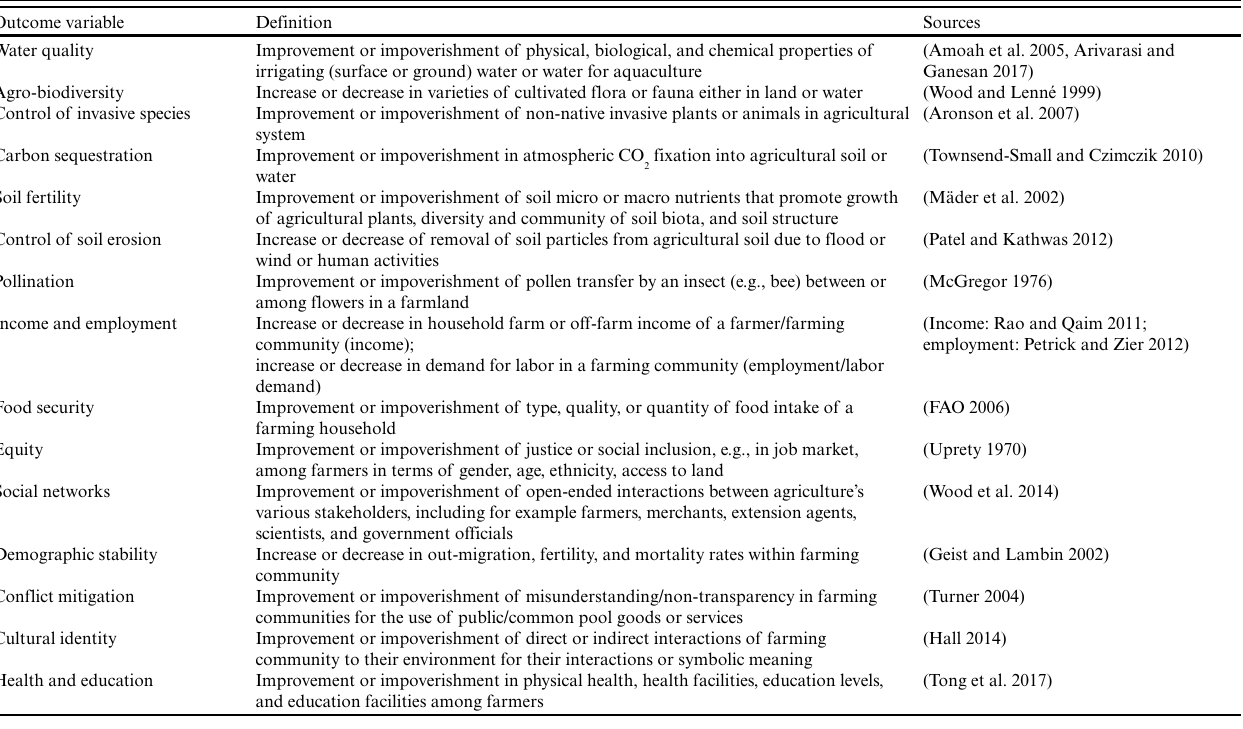
Table 1 . Outcome variables, their definitions, and the sources of their definitions Outcome variable